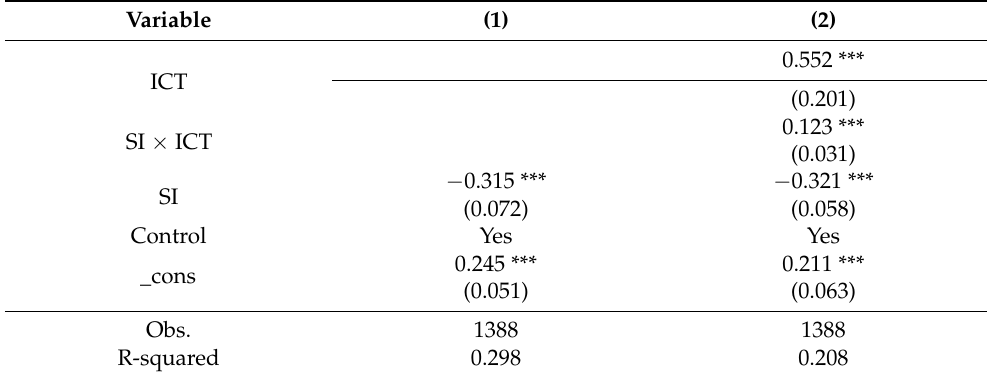
Table 5. Effect of ICTs on the relationship between land fragmentation and AMT adoption.